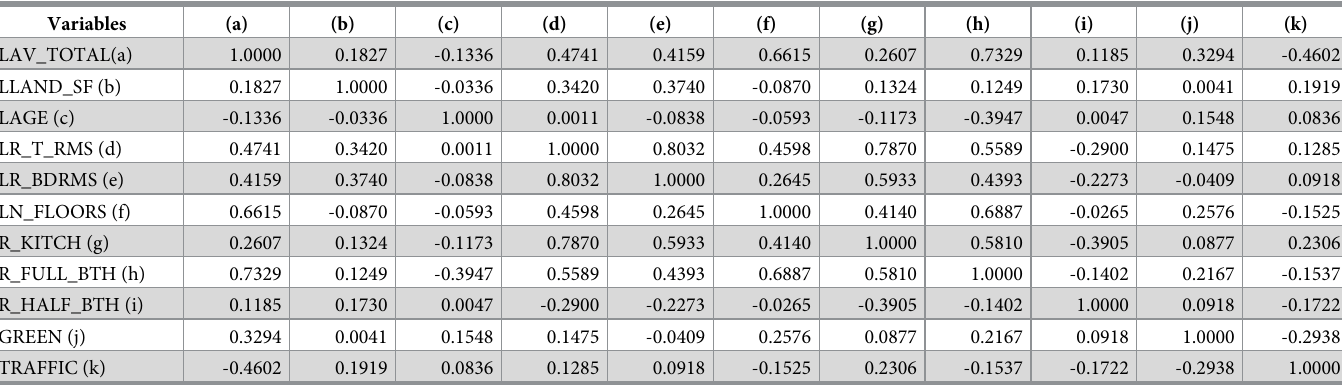
Table 2. Correlation coefficients of the house price and each